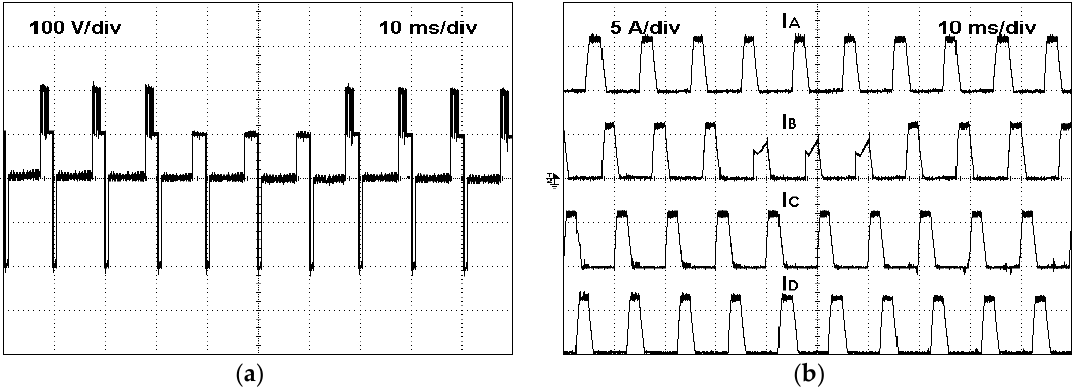
Figure 19. Experimental test with the converter operating in normal mode, then with an open-switch fault in the semiconductor S 12 ( a ) winding voltage of phase B and then in fault-tolerant mode; ( b ) winding currents.